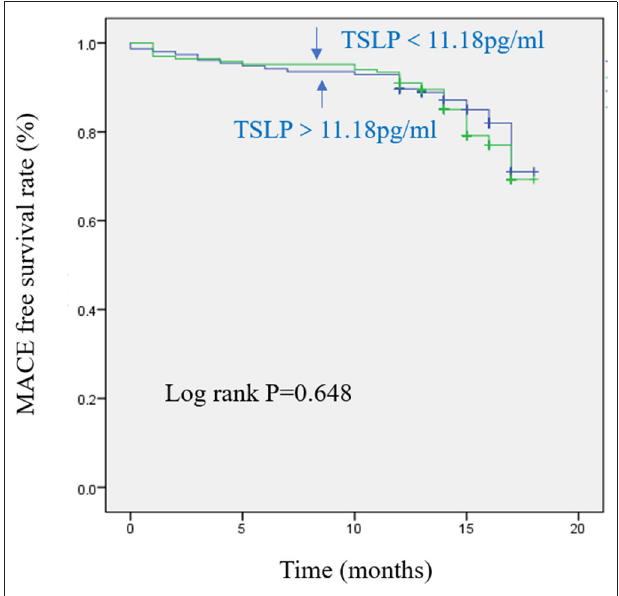
FIGURE 1 | Kaplan-Meier curves in patients with acute myocardial infarction (AMI) with individual levels of thymic stromal lymphopoietin (TSLP) during